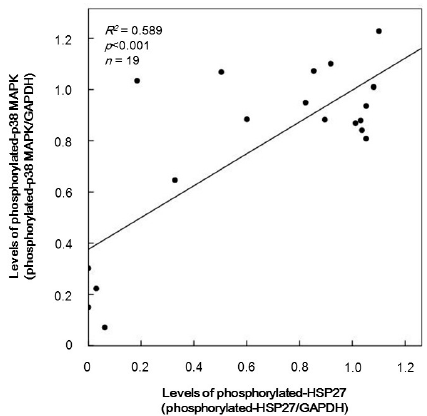
Figure 3. The relationship between individual levels of the phosphorylation of HSP27 (Ser-78) and p38 MAP kinase induced by TRAP in platelets from type 2 DM patients. The baseline levels in unstimulated samples were subtracted from each level of the individual HSP27 phosphorylation and p38 MAP kinase phosphorylation stimulated by 10 µM of TRAP for 4 min, and the net changes are presented as levels of phosphorylated-HSP27 (Ser-78) and phosphorylated-p38 MAP kinase, respectively. Each of the data were determined by a Western blot analysis using the ImageJ software program. These data were plotted and analyzed by linear regression analysis.